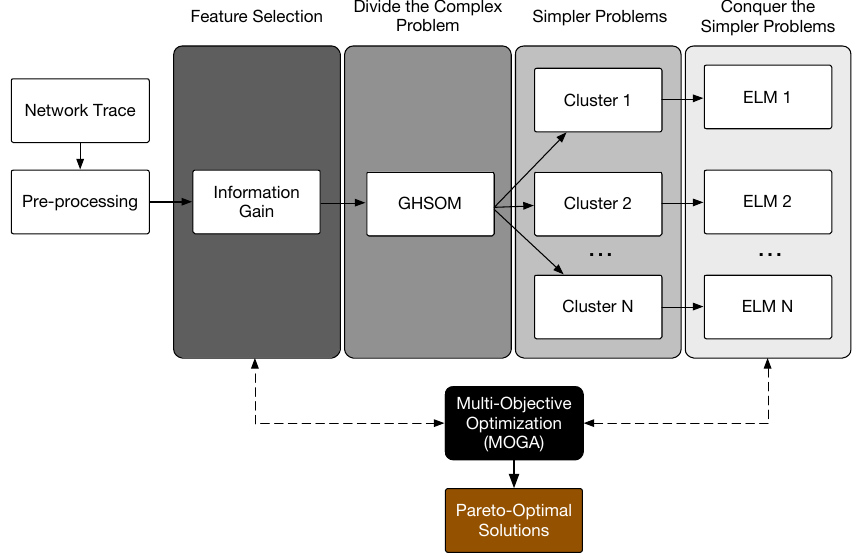
Figure 1. The proposed Multi-Objective Divide and Conquer (MODC) hybrid